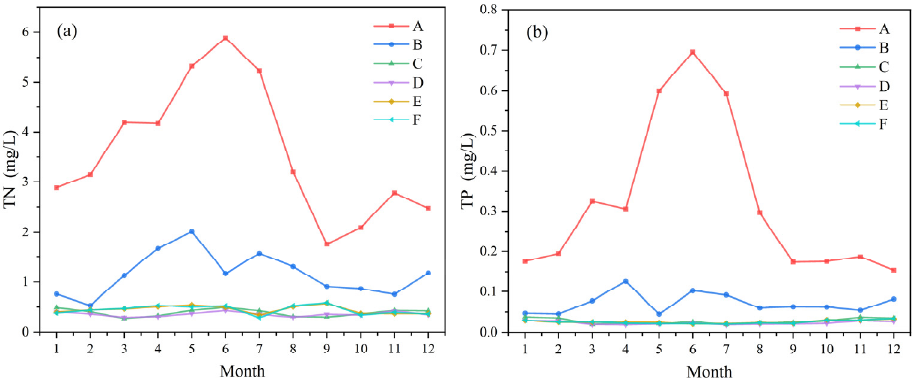
Figure 5. Intra-annual changes of ( a ) TN and ( b ) TP concentrations within the monitoring areas (A–